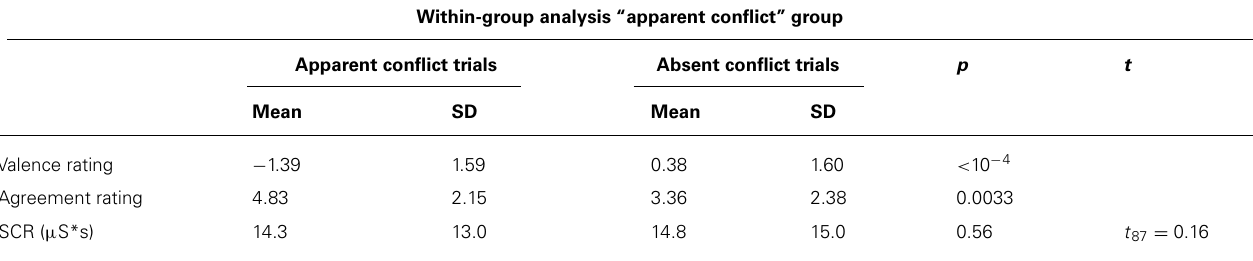
Table 3 | Comparison of valence and agreement ratings and skin conductance reactivity only within group 1 with “apparent conflict” between trials with and without “apparent